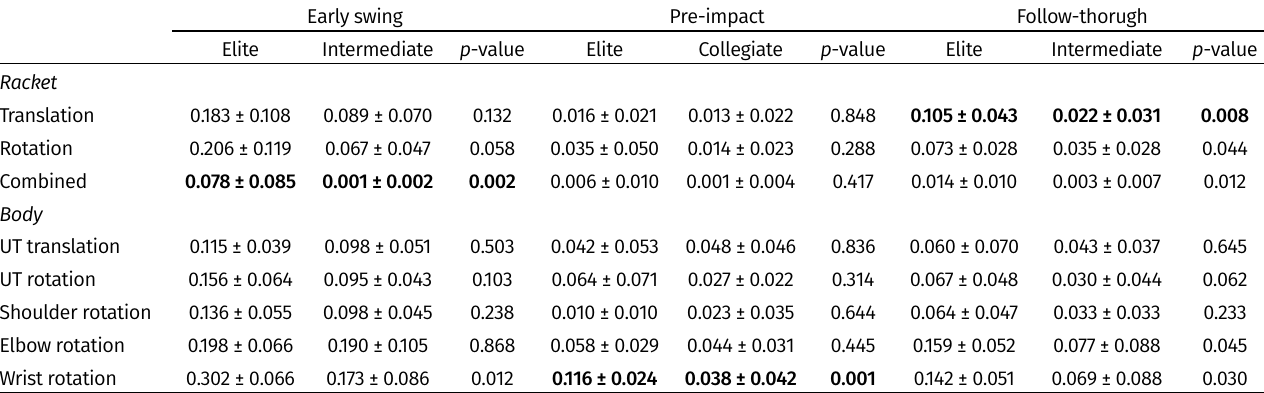
Table 3. Misclassification rates for racket and body kinematics during three phases of three serve types of elite and intermediate